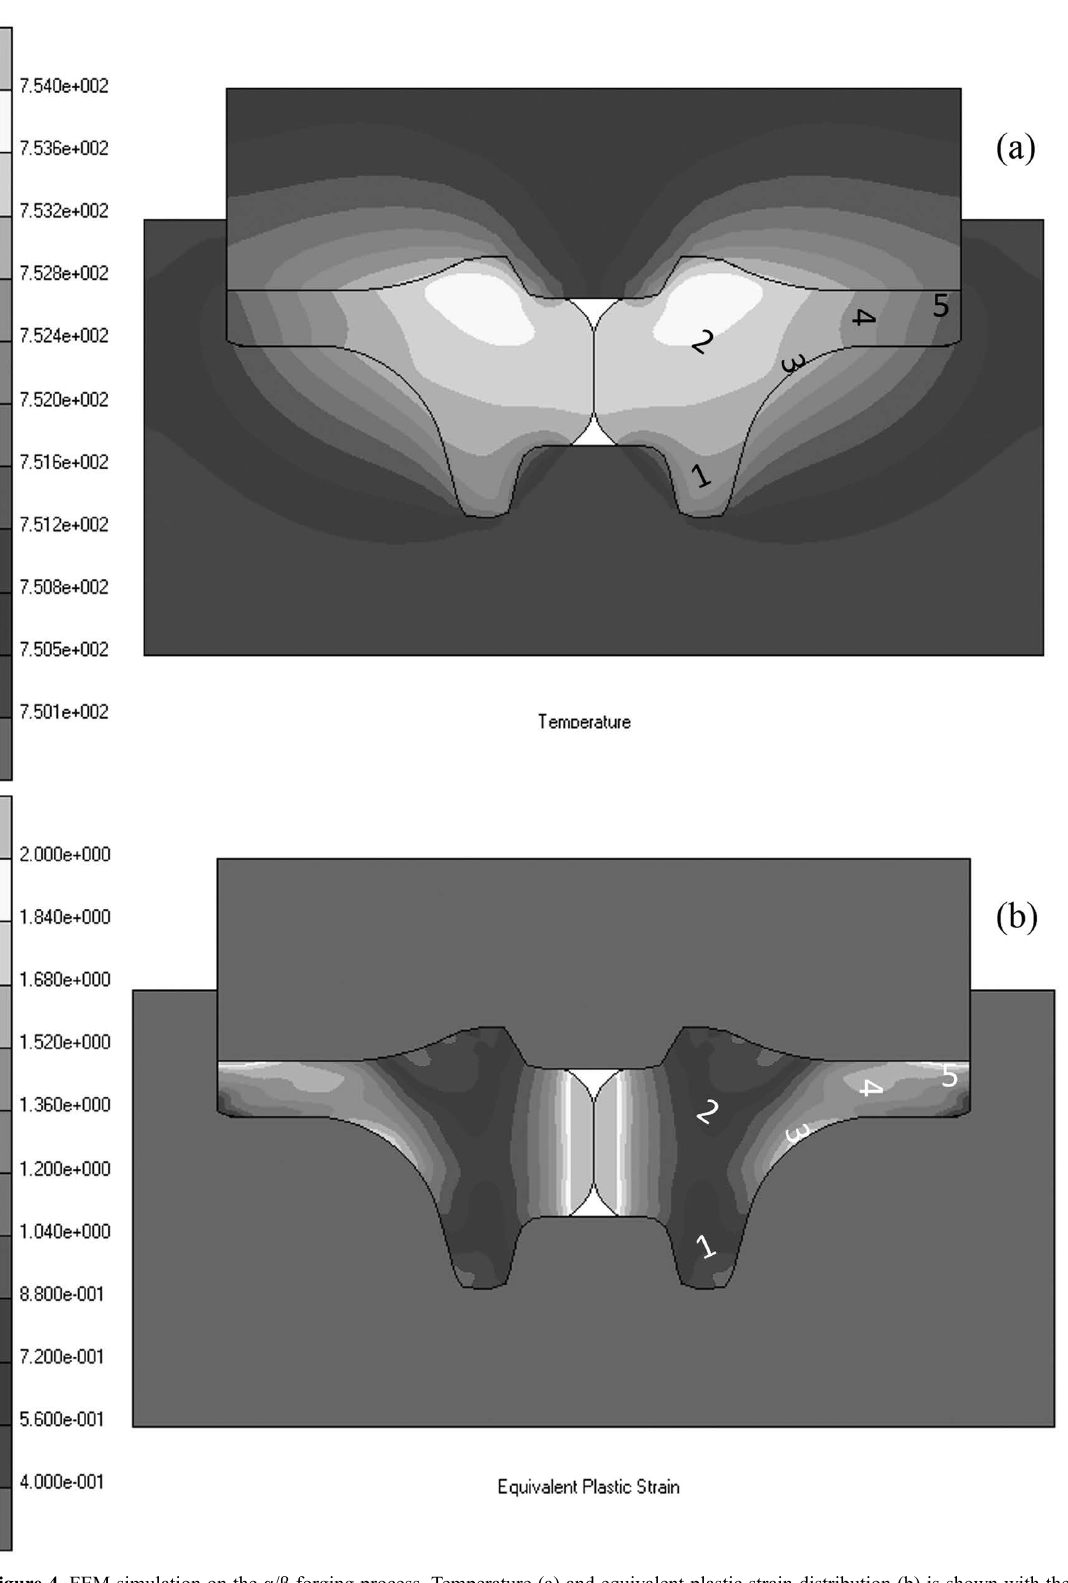
Figure 4. FEM simulation on the α/β forging process. Temperature (a) and equivalent plastic strain distribution (b) is shown with the gray counter on the left. Locations of different samples are marked with numbers in the